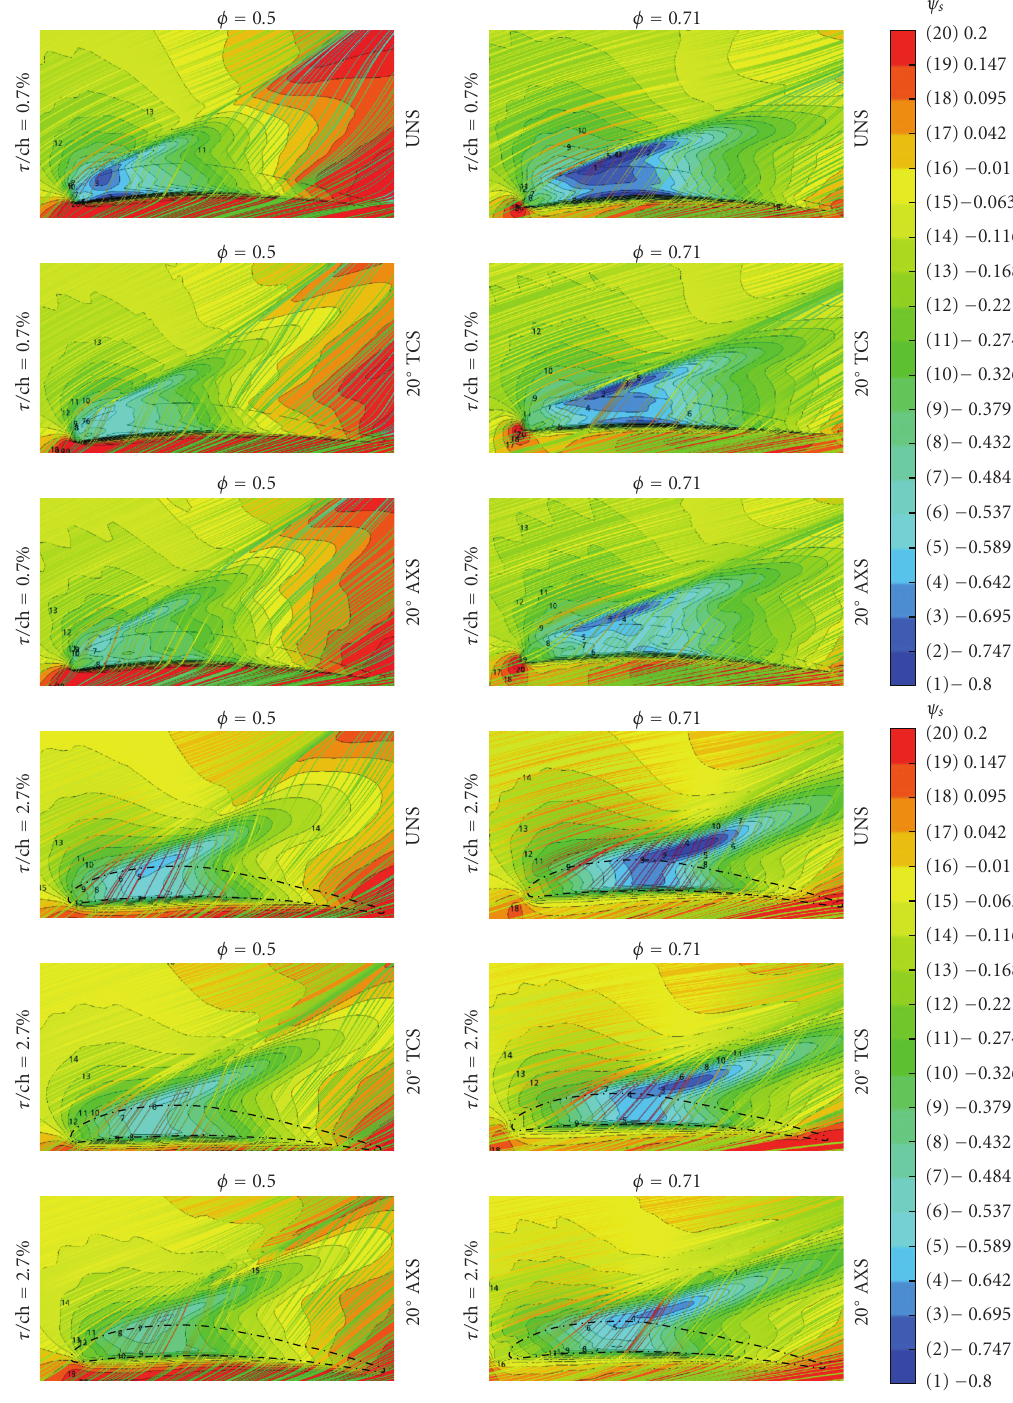
Figure 10: Total pressure coe ffi cient variation with streamline pattern on planes at mid tip gap height.